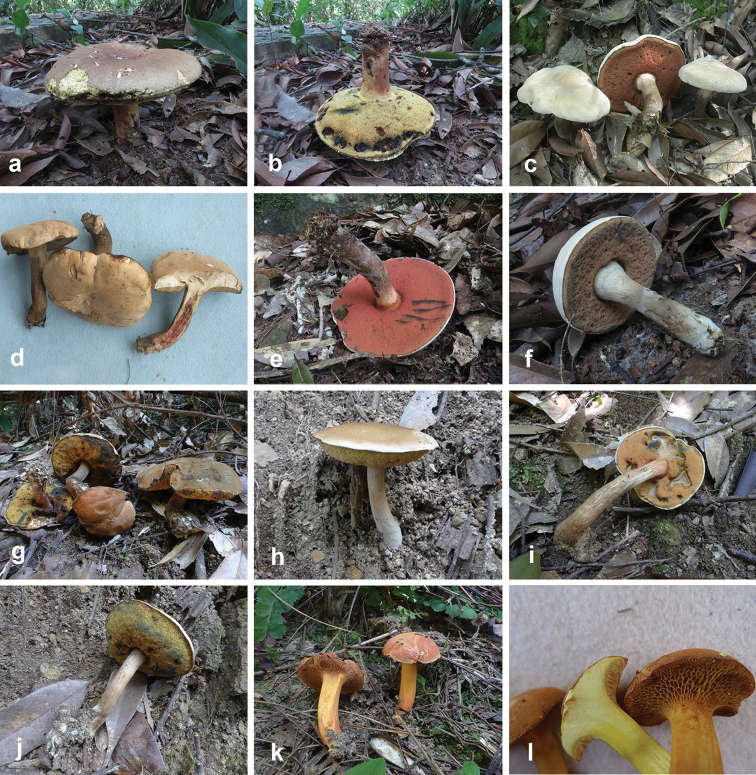

Basidiomata of boletes. a, bButyriboletushuangnianlaii (FHMU 2207, holotype) c–fCaloboletusguanyui (c–d from FHMU 399; e from FHMU 2224; f from FHMU 2222) g–jCaloboletusxiangtoushanensis (g from FHMU 883 h, j from FHMU 906 i from FHMU 884) k, lChalciporusradiatus (FHMU 930). Photos by N.K. Zeng.